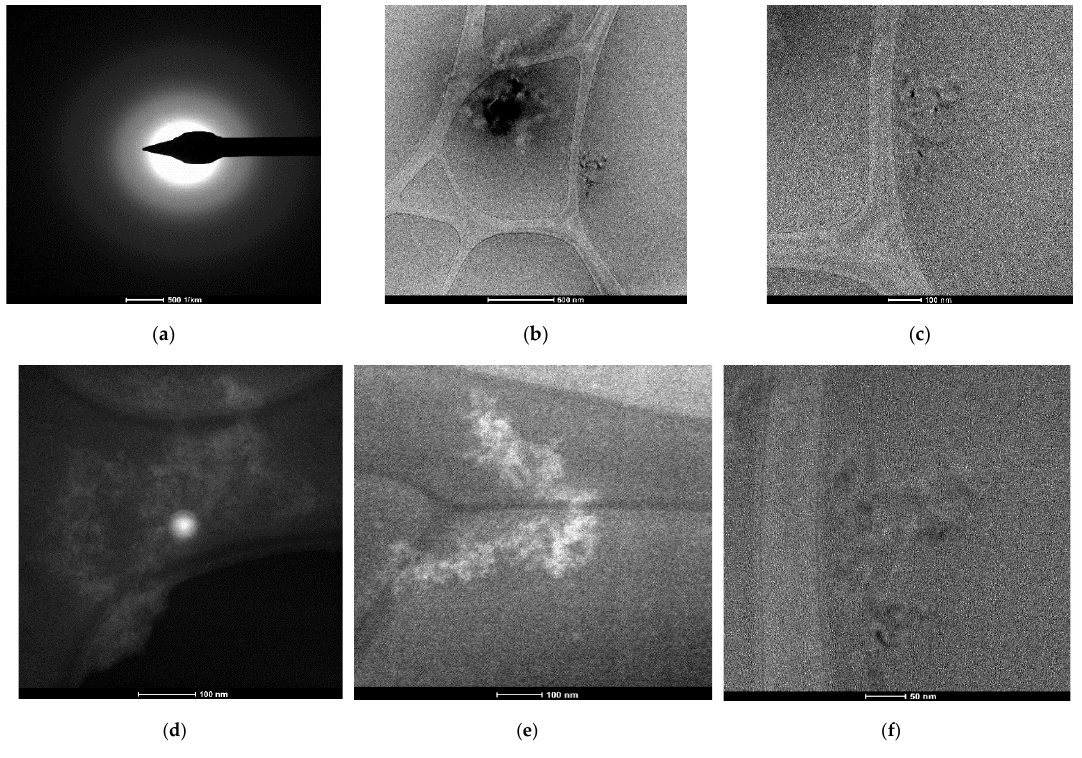
Figure 4. Transmission electron microscopy (TEM) images of the membrane nanodispersions before use in the process. ( a ) Selected area diffraction pattern and images at selected magnitudes of: ( b ) 500 nm; and ( c ) 100 nm. ( d ) Highlight of the exposure point at 100 nm; ( e ) The set of nanoparticles at 100 nm; ( f ) detail of the set of nanoparticles at 50 nm.